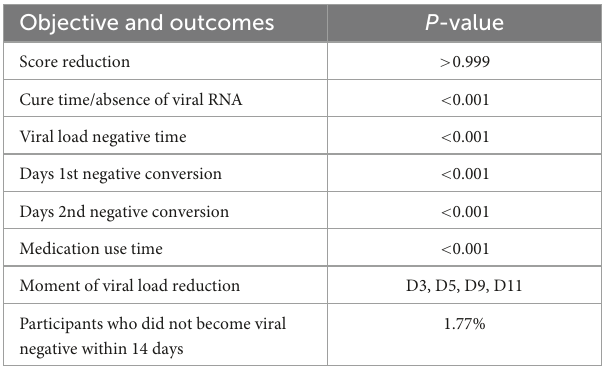
TABLE 1 Compilation of results of contrasts between FNC and placebo treatments on study